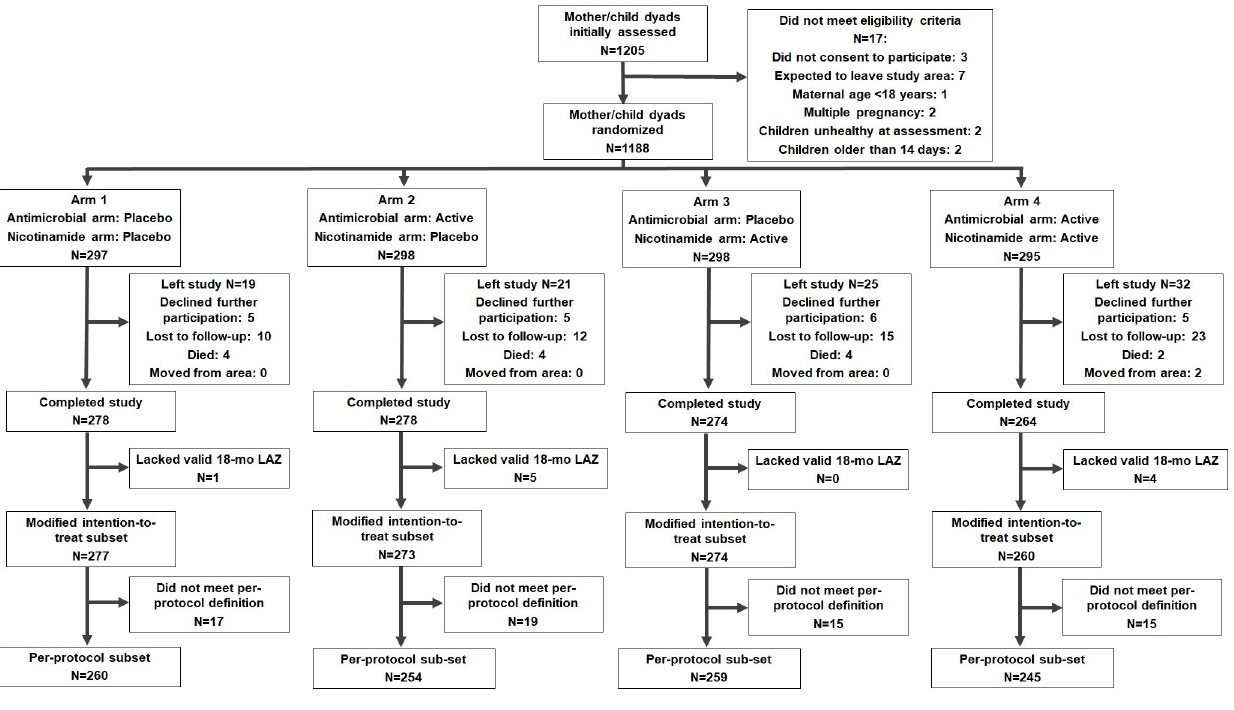
Fig 1. Trial profile by intervention